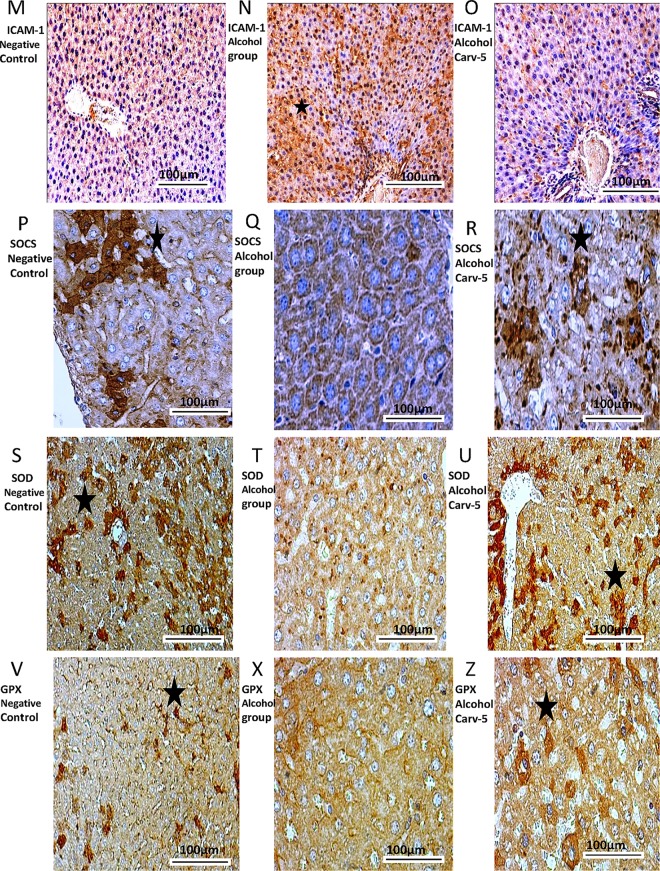
ICAM-1, SOCS1, SOD-1, and GPx immunohistochemical findings.Livers from alcohol-administered rats had greater ICAM-1 (N) immunoreactivity than the saline control and alcohol-CARV 5 mg/kg group rats. Livers from alcohol-administered rats had reduced SOCS1 (Q), SOD-1 (T), and GPx (X) immunoreactivity levels than the negative control and alcohol-CARV 5 mg/kg group rats. For each antigen, three immuno-labelled sections were analysed per animal (N = 5 animals per group). Asterisk: strong labelling. Magnification 4000×, scale bar = 100 μm.